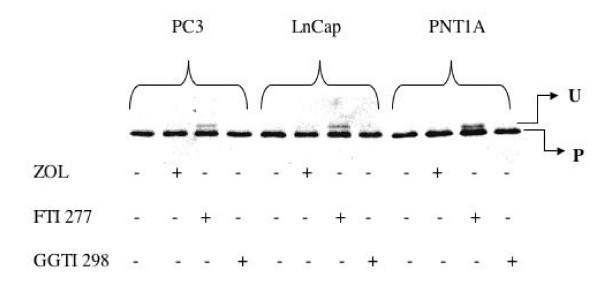
Effect of zoledronate on farnesylation status of HDJ2. Prostatic cells where treated for 48 h with ZOL (20 μM), lysed in hot (90°C) SDS (1%) and analyzed by Western blot.